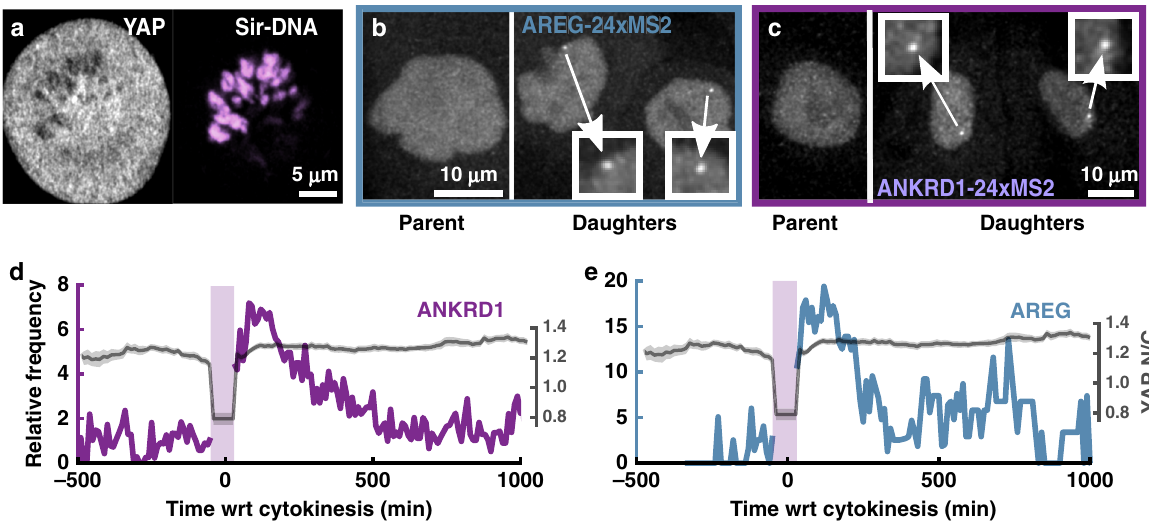
Fig. 7 YAP localization-reset and transcription activation following mitosis. a Representative YAP localization (gray) in a dividing cell (condensed chromatin shown in magenta). Repeated twice with similar results in all cells. b , c Example of MCF10A AREG -MS2-KI b and MCF10A ANKRD1 -MS2-KI c cells going through mitosis. Insets show nascent transcription spots in both daughter cells. d , e Left axis: mean transcription frequency of cells showing transcription reset after mitosis for ANKRD1 ( d ) and AREG ( e ). Mitotic events collected from two independent experiments for both ANKRD1 ( N = 39 divisions) and AREG ( N = 25 divisions). Right axis: mean YAP N / C during division ( N = 24 divisions). The N / C ratio during mitosis was calculated as the mean value from seven high-magni fi cation images of mitotic cells expressing YAP (as shown in a